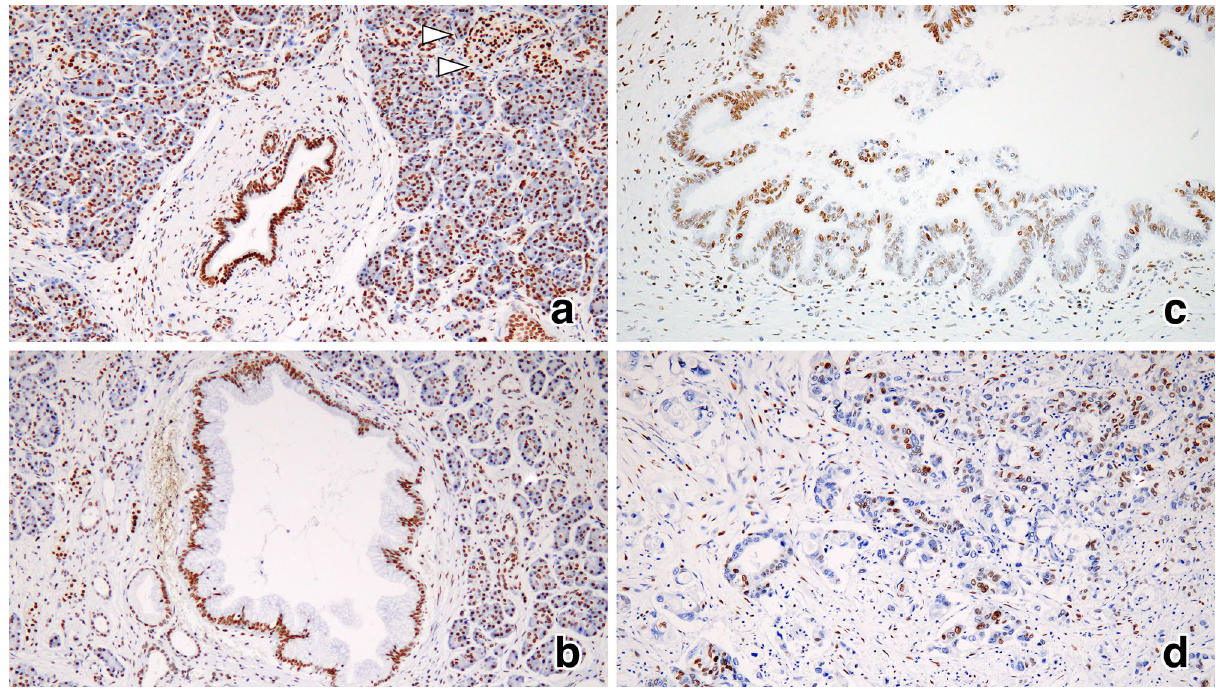
Figure 5. Immunohistochemical analysis of HIPK2 expression. HIPK2 was expressed in nuclei in pancreatic ducts, acinar cells, and islet cells in normal pancreatic tissue ( a ) and in low-grade PanIN ( b ). In high-grade PanIN ( c ) and PDAC ( d ), HIPK2 was focally negative or weakly expressed.